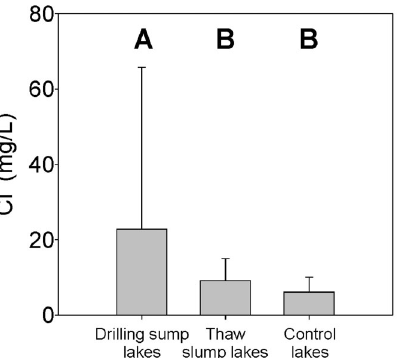
Figure 2. Mean chloride concentration in the 101 lake dataset separated into three apriori defined groups. Vertical error bars representing the standard deviation are included. Letters A and B indicate drilling-sump impacted lakes have significantly higher chloride levels than either thaw-slump affected lakes or control lakes, which are not statistically different (Tukey HSD post-hoc test, following ANOVA